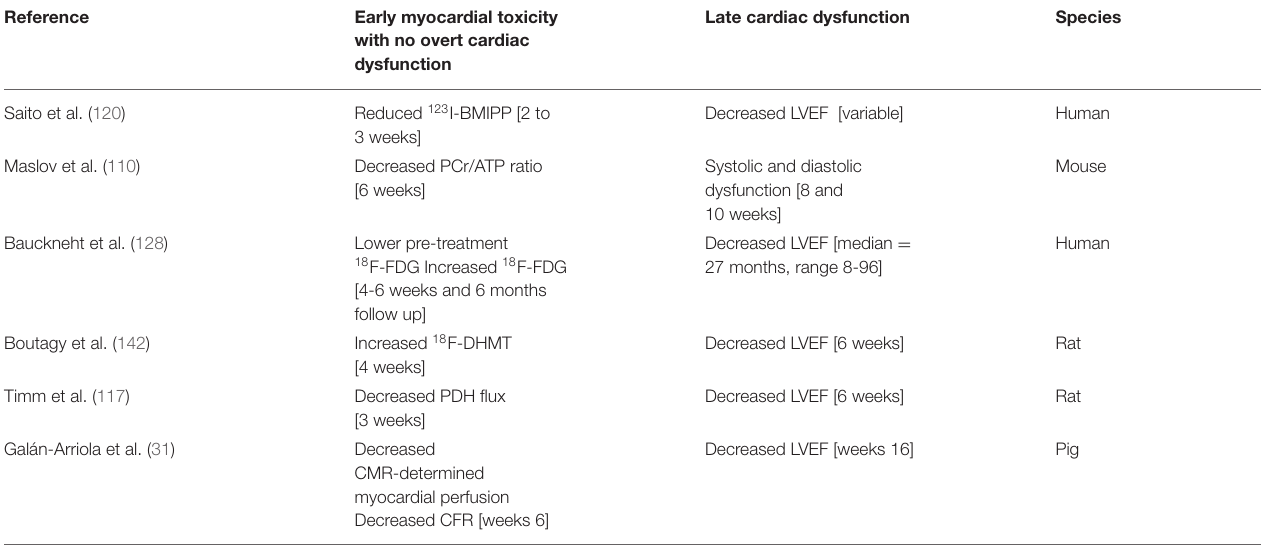
TABLE 2 | This table summarizes early perfusion, metabolic and mitochondrial function imaging findings suggestive of DOX myocardial toxicity that subsequently revealed impaired left ventricle ejection